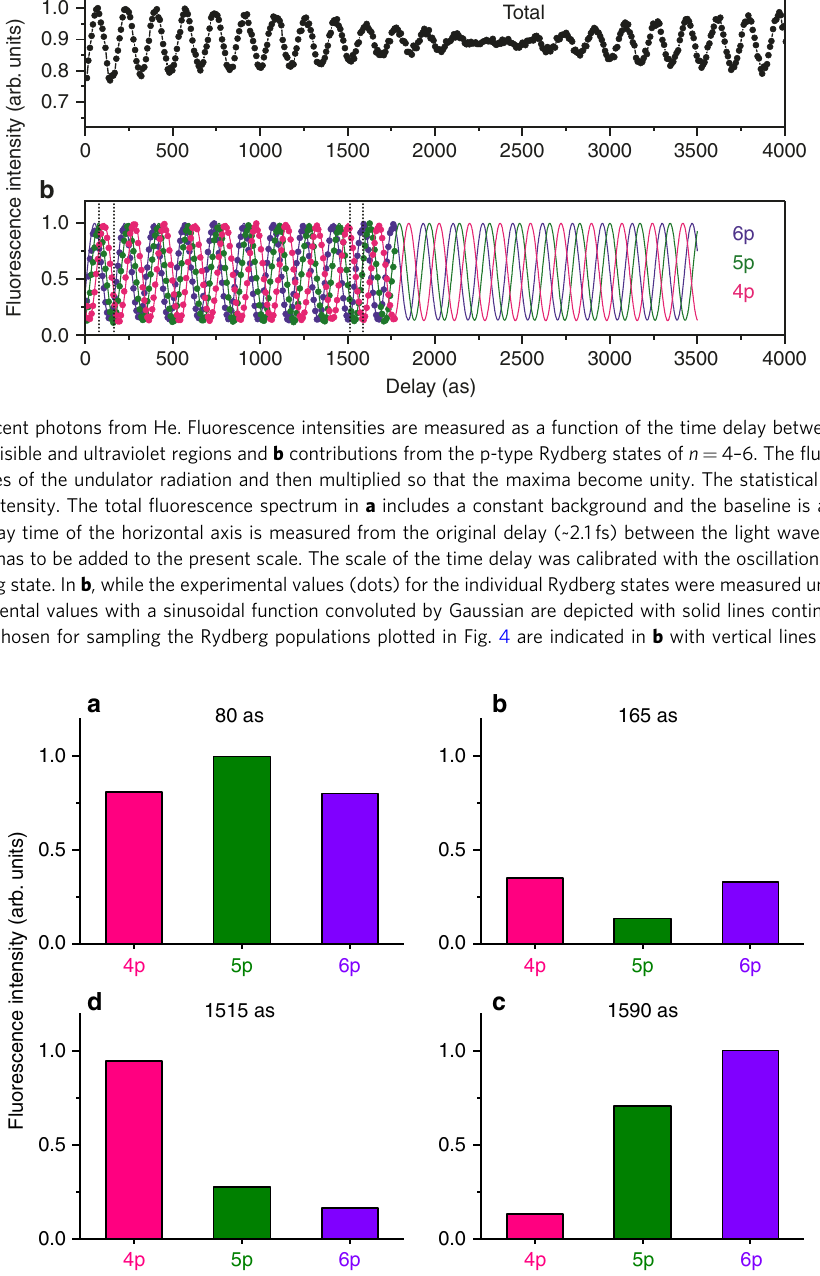
Fig. 4 Populations of Rydberg states. Populations of 4p, 5p, and 6p Rydberg states in He at four different time delays between the light wave packets, extracted from the Ramsey-fringe spectra in Fig. 3b. The statistical error of each value is in 1 –